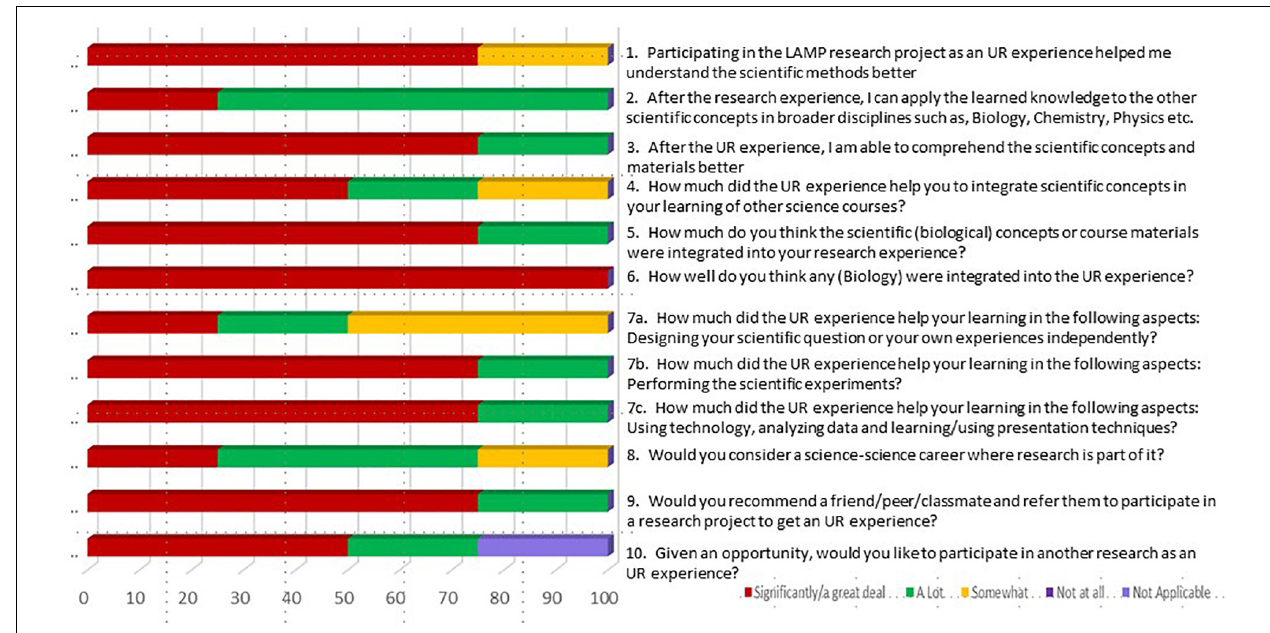
FIGURE 7 | Survey of student attitudes. An anonymous survey was conducted using Google forms.